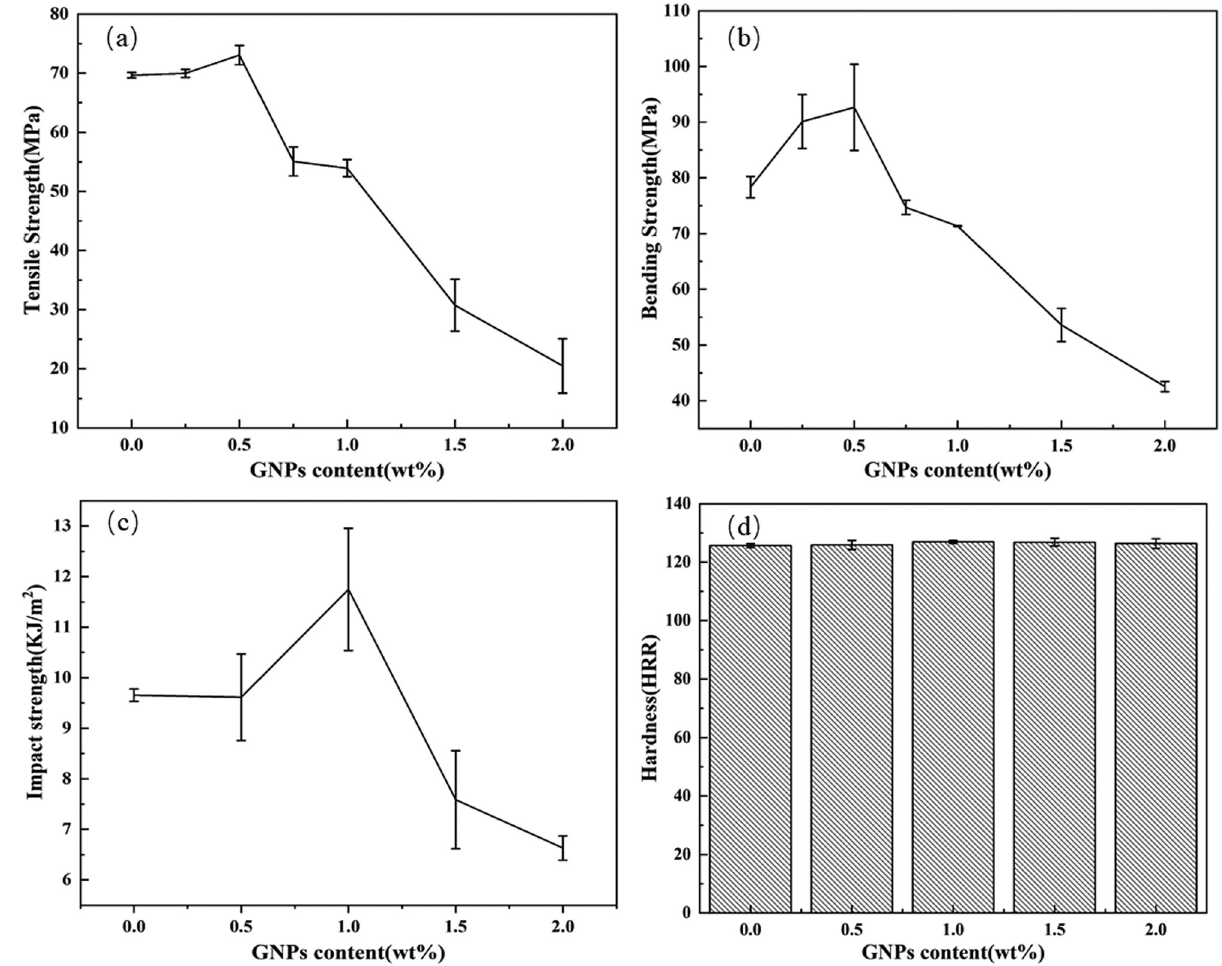
Figure 4: Di ff erent mechanical property curves of polyimine and di ff erent GNPs - P composites: ( a ) tensile strength, ( b ) bending strength, ( c ) impact strength, and ( d ) hardness